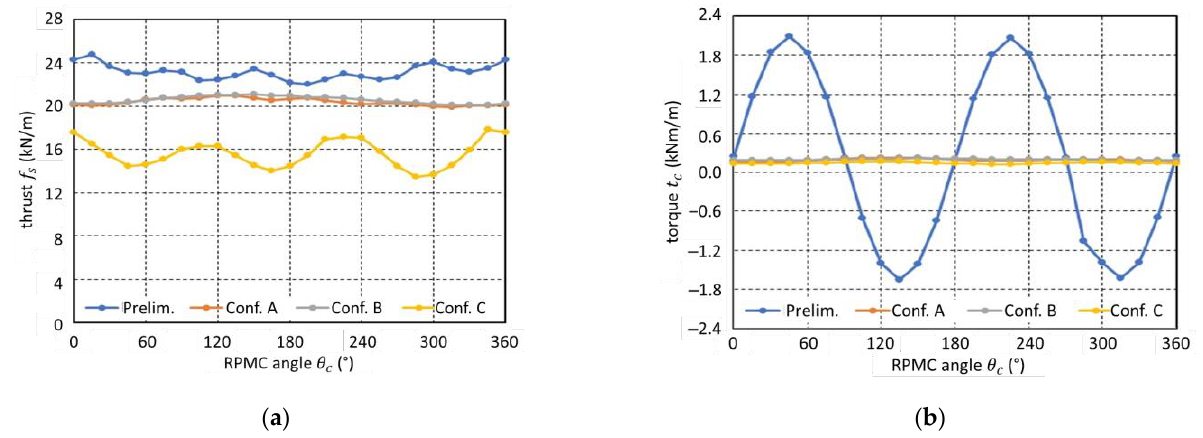
Figure 7. Comparison of the pu depth thrust ( a ) and torque ( b ) for different RPMC arrangements (Conf. A with Δ𝜃 𝑠 = 60°).